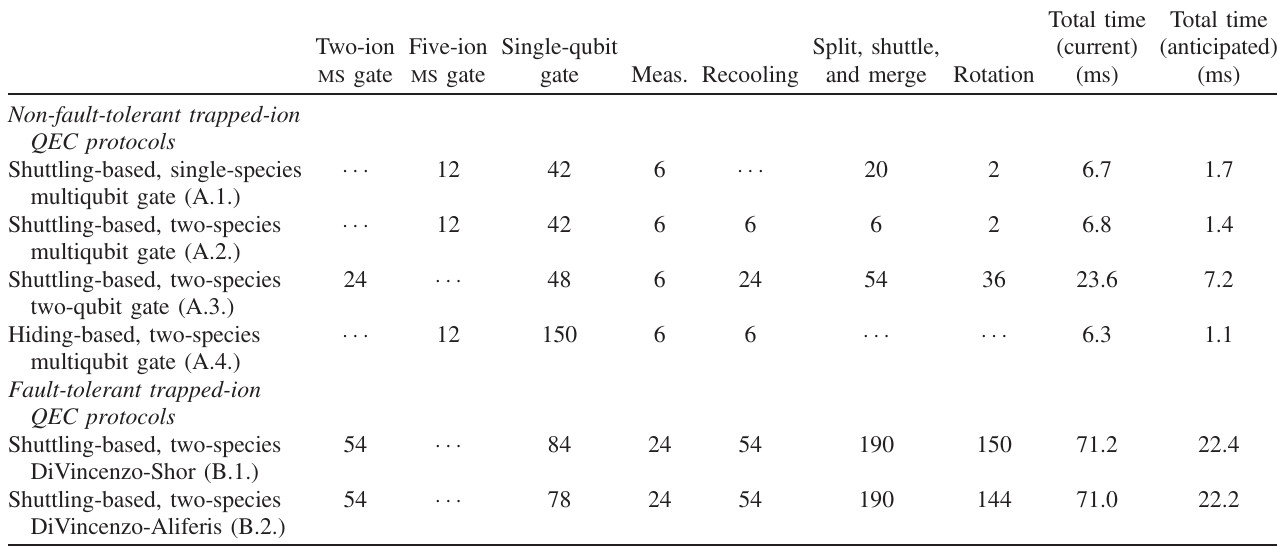
TABLE VI. Resource overview for the different QEC protocols. We describe the number of various operations that conform each QEC cycle [i.e., measurement of all the six stabilizers, Eq. (23)] within the different trapped-ion protocols introduced in Sec. VI. The number of basic operations can be obtained from the different schemes presented in the Figs. 15 – 22. In the two rightmost columns, we present the total time required for each QEC cycle according to the current and anticipated values given in Tables II and IV. Note, however, that some of the local single-qubit gates require the use of refocusing techniques that combine various single-qubit gates and that some operations can be done in parallel in different manipulation zones of the ion trap. The latter can lead to a minimization of the overall time of the QEC cycle (see Table VII for the optimized QEC cycle times).